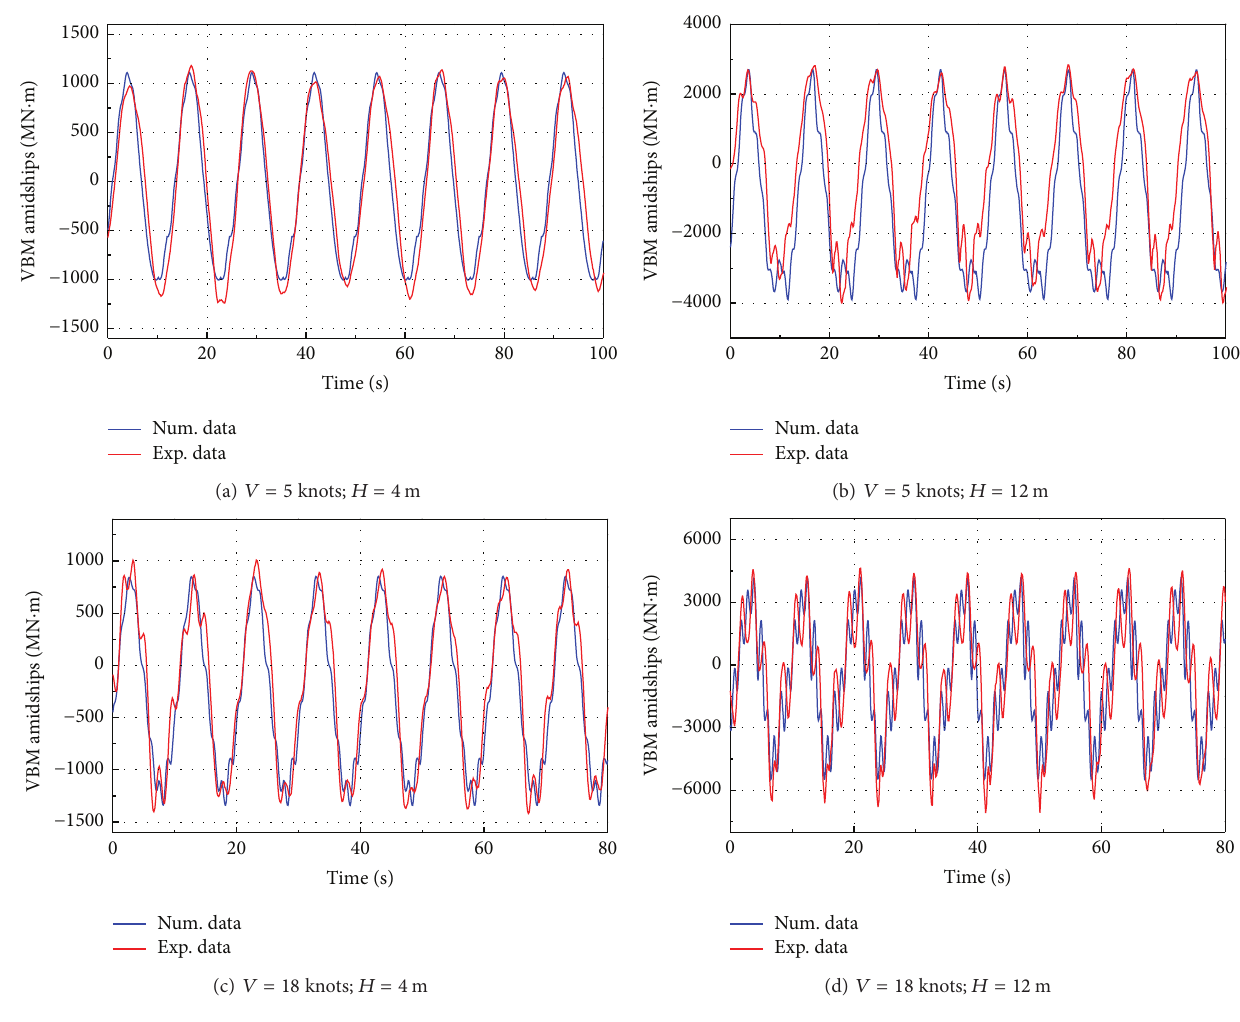
Figure 17: Comparison of the